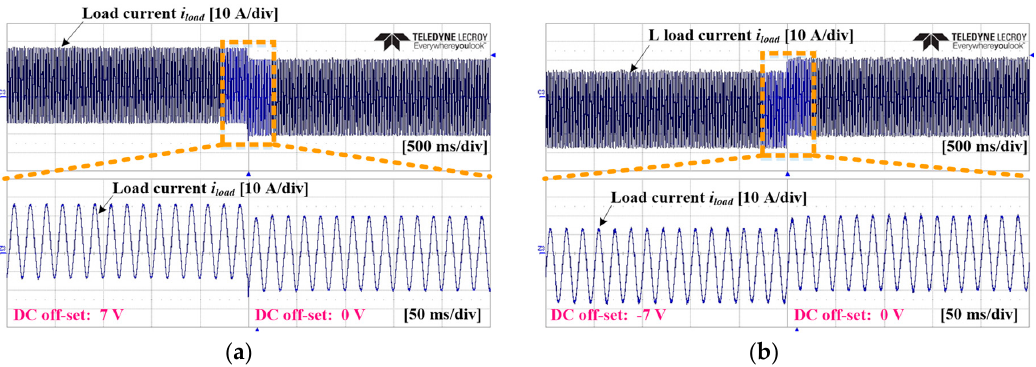
Figure 12. Experimental results for the DC-offset control. ( a ) DC offset: 7 A → 0 A; ( b ) DC offset: − 7 A → 0